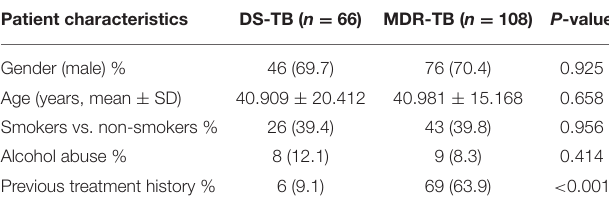
TABLE 1 | Comparison of clinical characteristics of the patients with DS-TB and MDR-TB. Patient